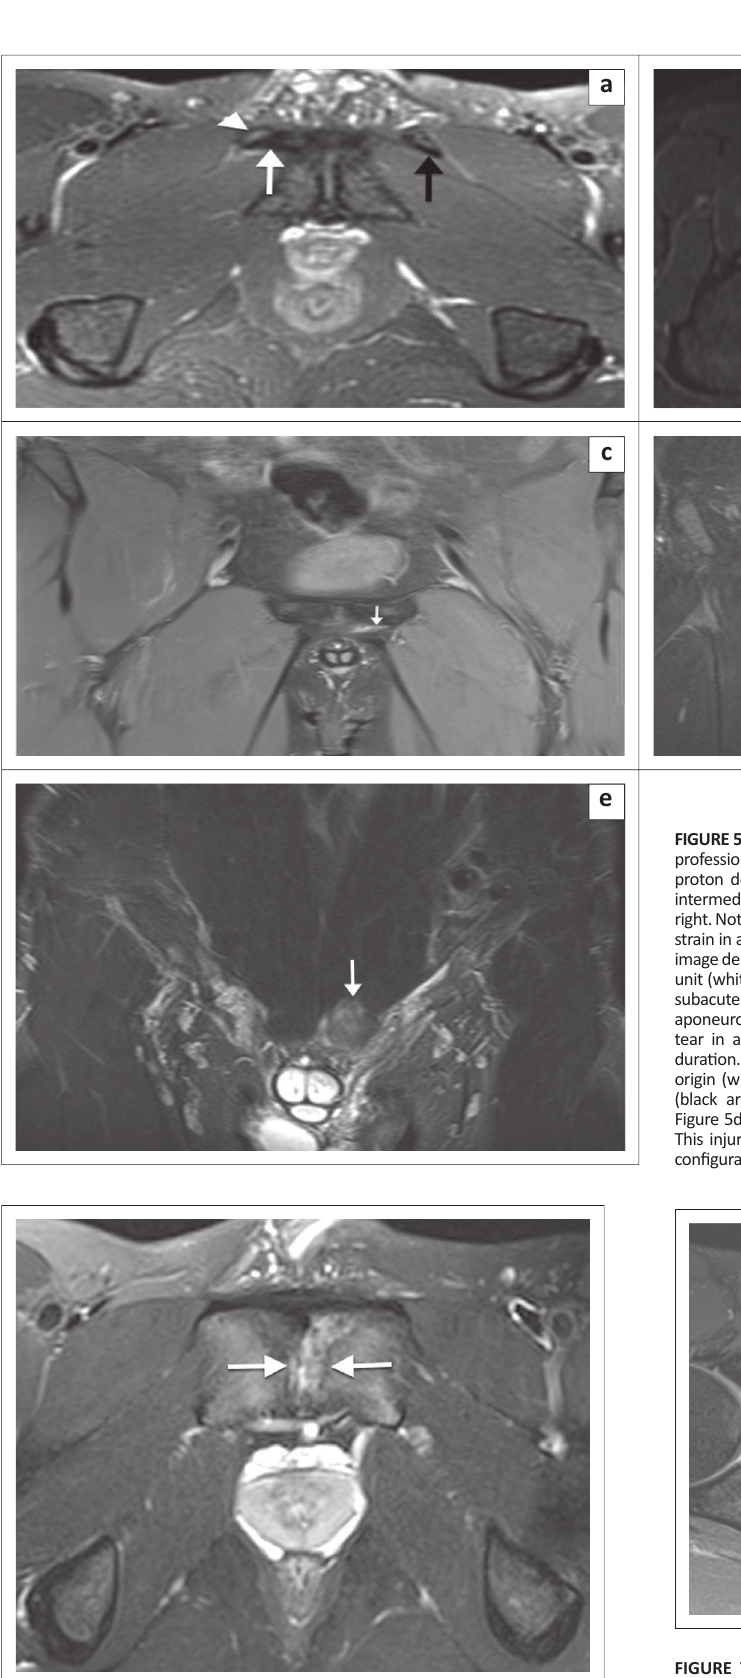
FIGURE 6: Osteitis pubis in a 21-year-old soccer player with left groin pain. Axial fat-saturated proton density (PD) image demonstrates bilateral and asymmetric bone marrow oedema in the symphysis pubis (white arrows). The hallmark of osteitis pubis is that the bone marrow oedema extends through the entire sagittal dimension of the bone as seen on the left in this athlete. See Figure 4 for correlative pelvic radiograph.